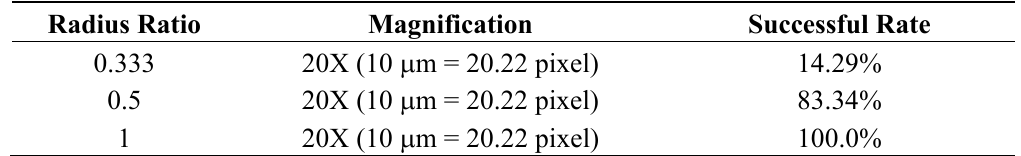
Table 3. The relationship between radius ratios and positioning successful rate with voltage as control